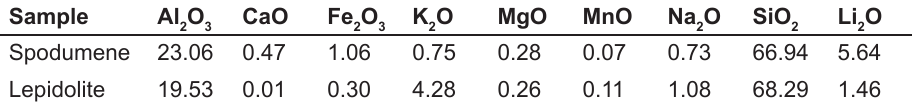
Table 1. Chemical composition of spodumene and lepidolite concentrates by ICP analysis.